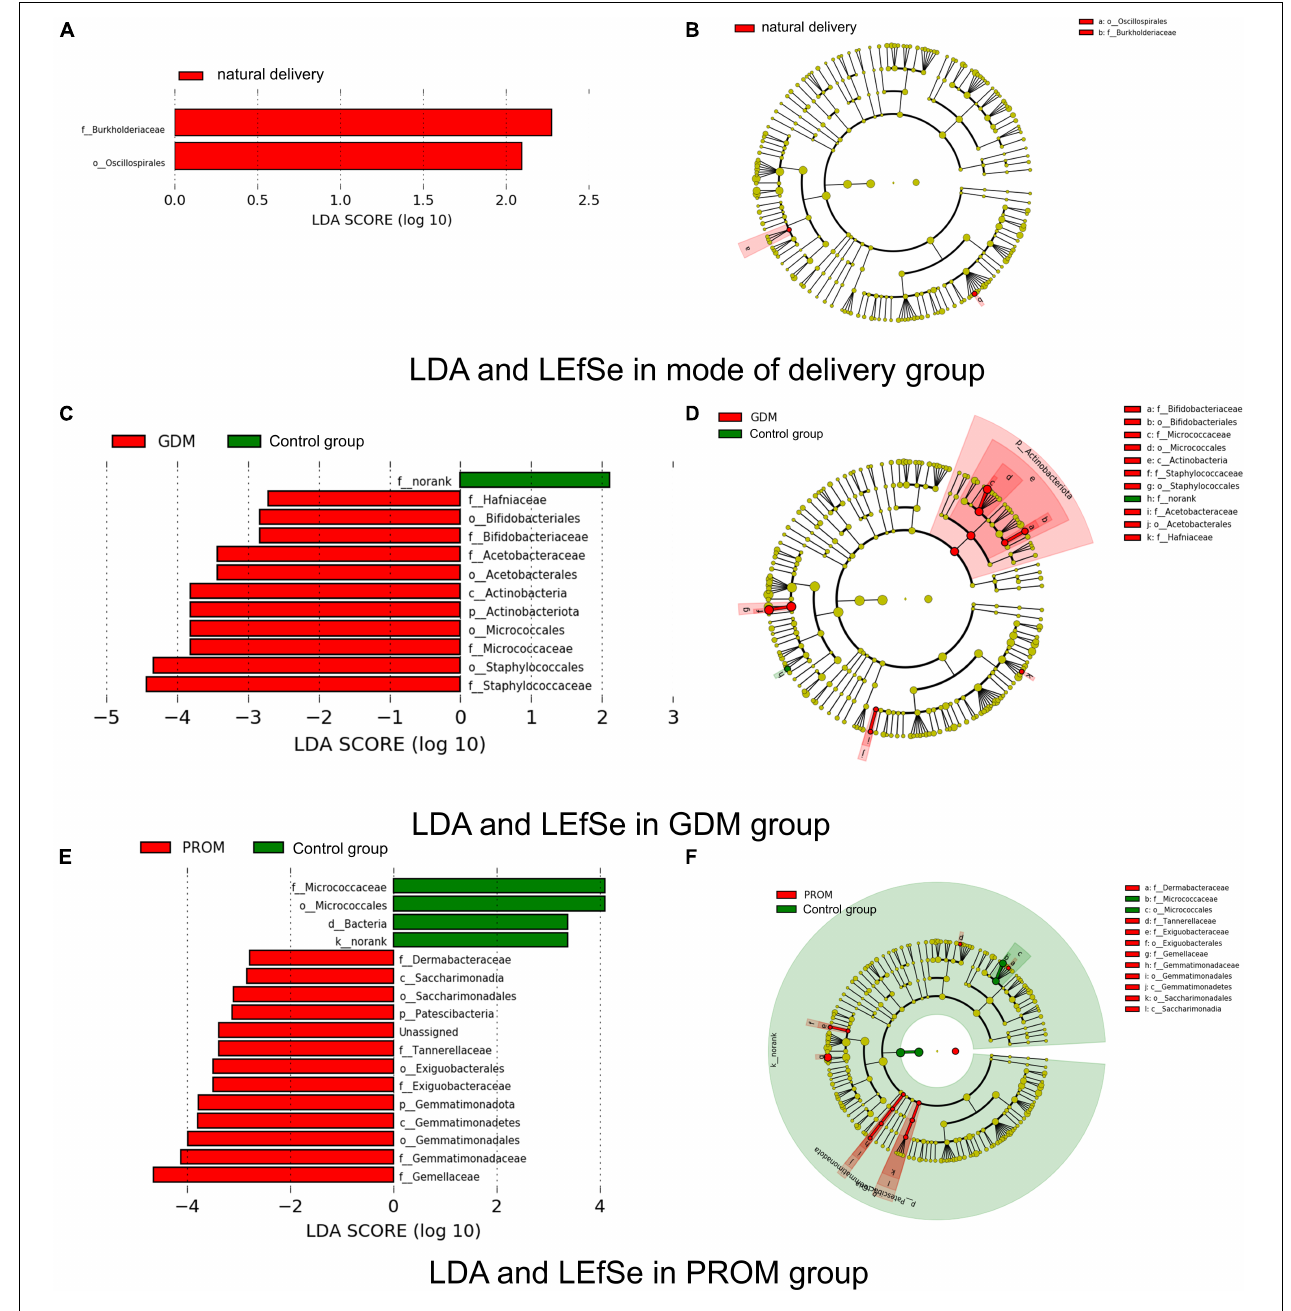
FIGURE 4 | Different genera measured by LDA and LEfSe in mode of delivery (A,B) , PROM (C,D) , and GDM (E,F) group.